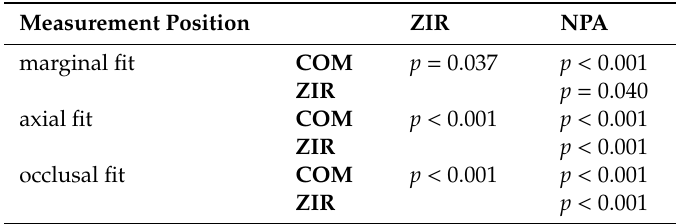
Table 3. P -values of the internal gap pairwise comparison ( p -value < 0.05, COM = resin composite, ZIR = zirconium dioxide and NPA = non-precious